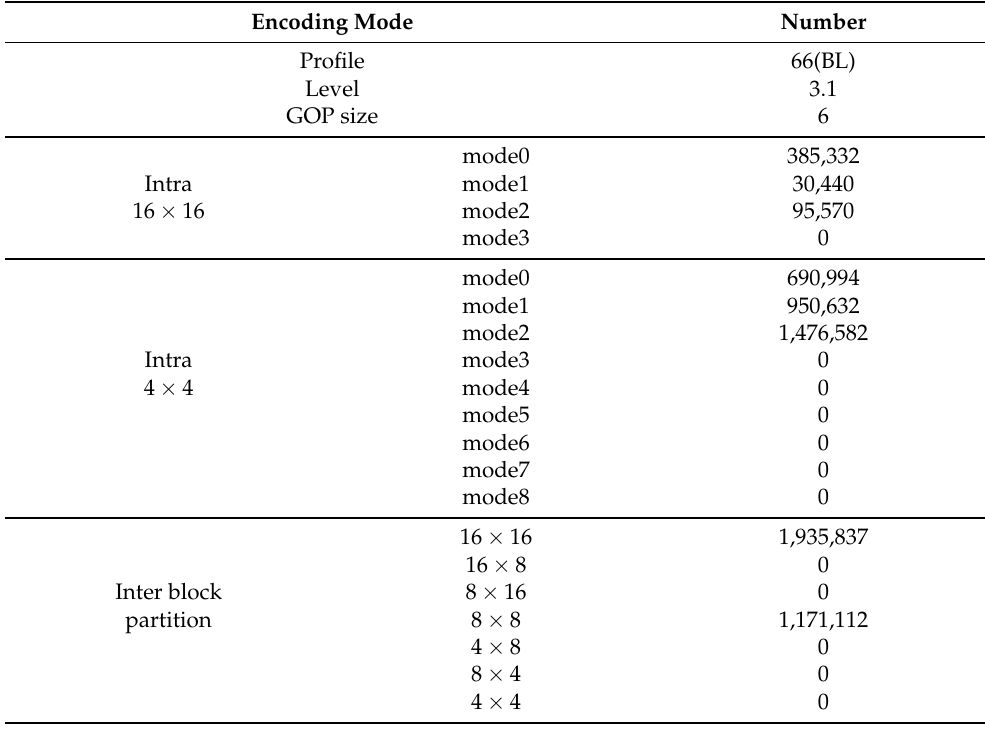
Table 1. Example of the H.264 decoder’s descriptor. BL stands for